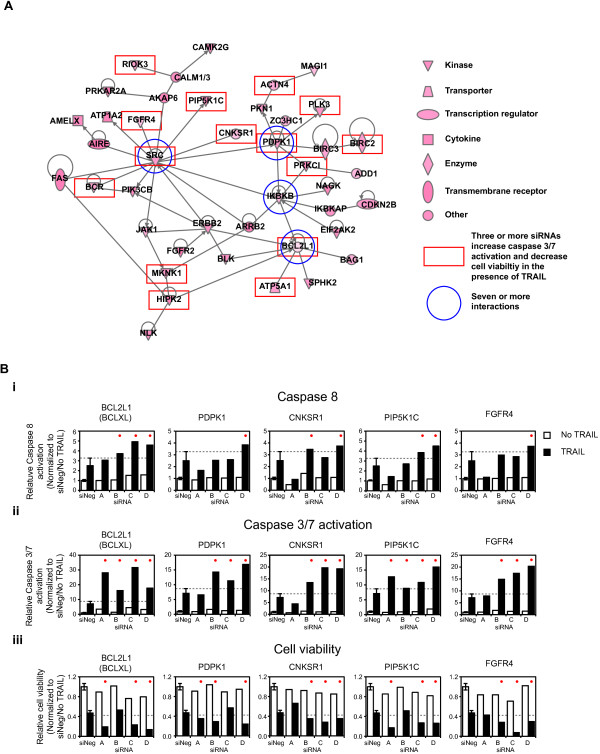
Network analysis of putative negative regulators of TRAIL-induced apoptosis. (A) A gene-interaction network generated by Ingenuity Pathway Analysis of the 150 genes for which three or more siRNAs induced increased TRAIL-induced activation of caspase-3/7 levels. The blue circles indicate those genes with seven or more interactions, and the red rectangles, genes for which three or more siRNAs caused both an increase in TRAIL-induced activation of caspase-3/7 levels and decreased viability in response to TRAIL. Legend shows the symbols indicated by the Ingenuity Pathway Analysis software. (B) Assays of (i) caspase-8, (ii) caspase-3/7 activation, and (iii) cell viability in the absence (empty bars) and presence (black bars) of TRAIL for four siRNAs (A-D) corresponding to the genes shown. Average data (±1 standard deviation) for negative control siRNA (siNeg)-transfected cells is shown in each graph. The grey dashed line indicates the relevant 1 standard deviation value for each assay, and the red dots indicate those siRNAs inducing fold-changes greater than 1 standard deviation.